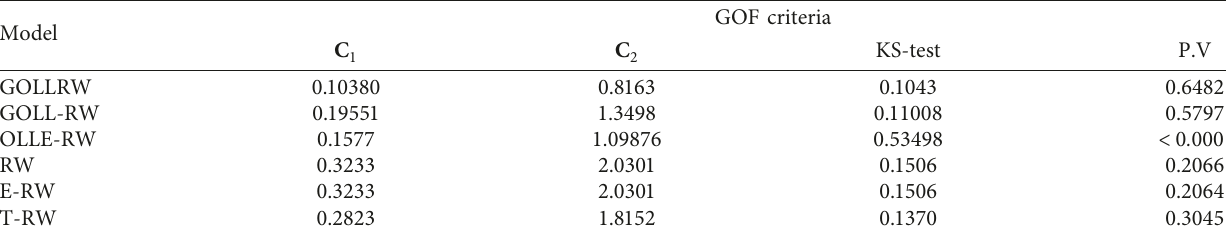
Table 12: C 1 , C 2 , KS-test, and P.V for relief time data